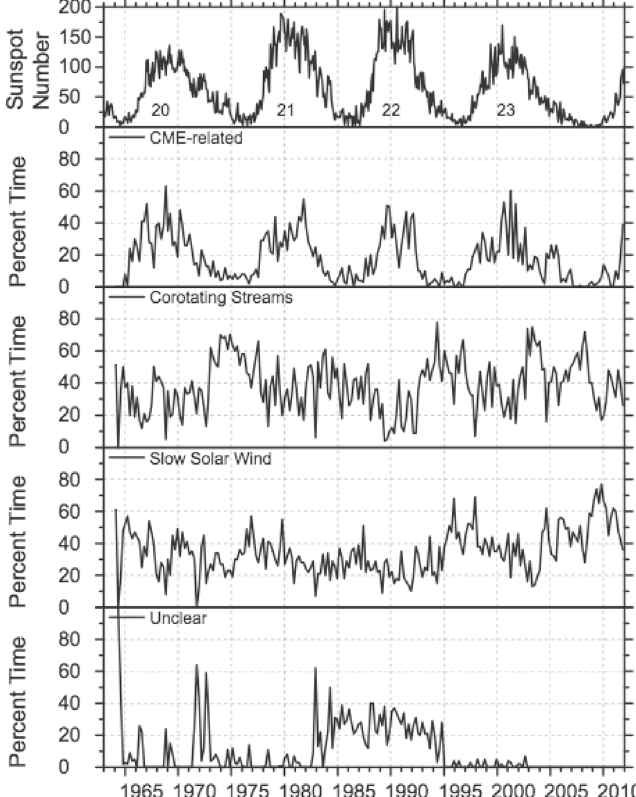
Fig.23 Thetoppanelshowsthemonthlysunspotnumber.Thenextthreepanelsshowthepercentage(three solar rotation averages) of the solar wind flows associated with ICMEs, high-speed streams and solar solar wind for over more than four solar cycles (1963–2011). The figure is from Richardson and Cane